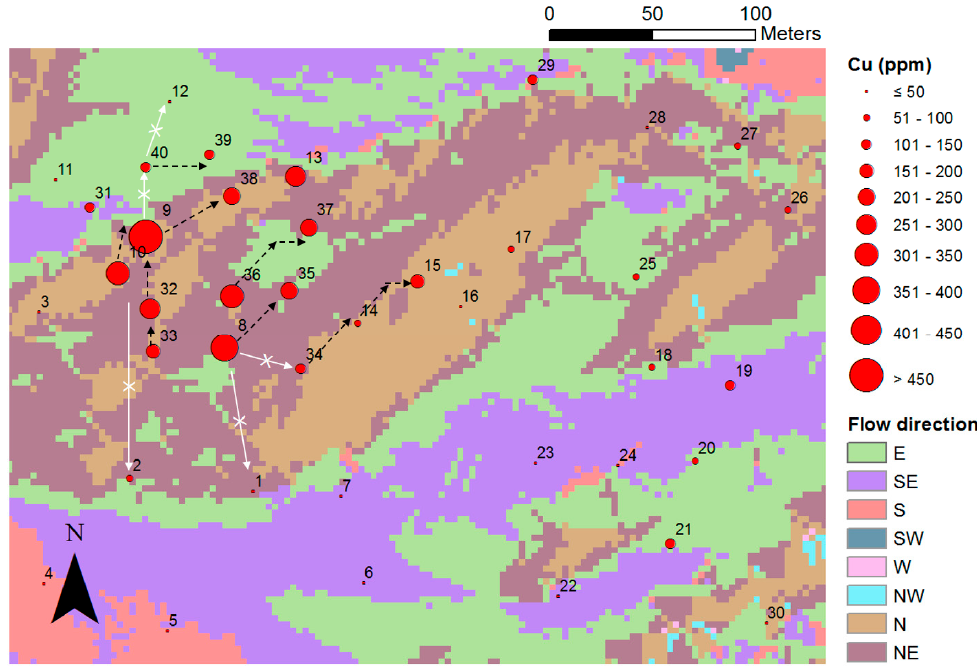
Figure 2. DEM ‐ based hydrological analysis used to examine the effect of the single ‐ flow direction of Figure 2. DEM-based hydrological analysis used to examine the effect of the single-flow direction of rainwater on Cu dispersion (modified from Suh et al. [13]). rainwater on Cu dispersion (modified from Suh et al.